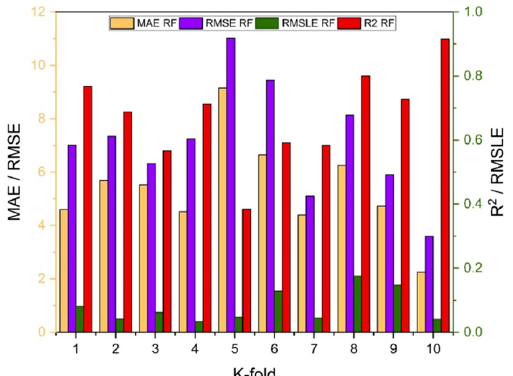
Figure 24. RF models cross validation with different statistical parameters .